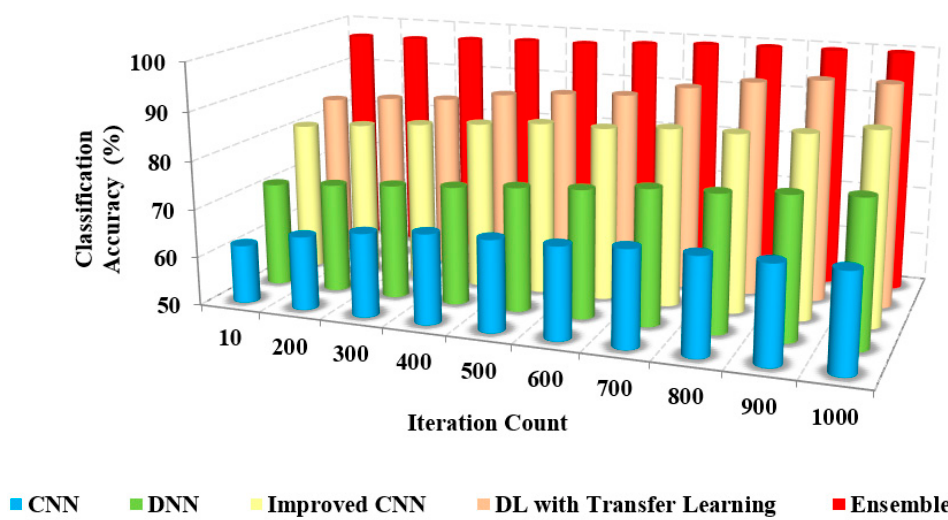
Figure 6. Iteration count vs. classification accuracy.